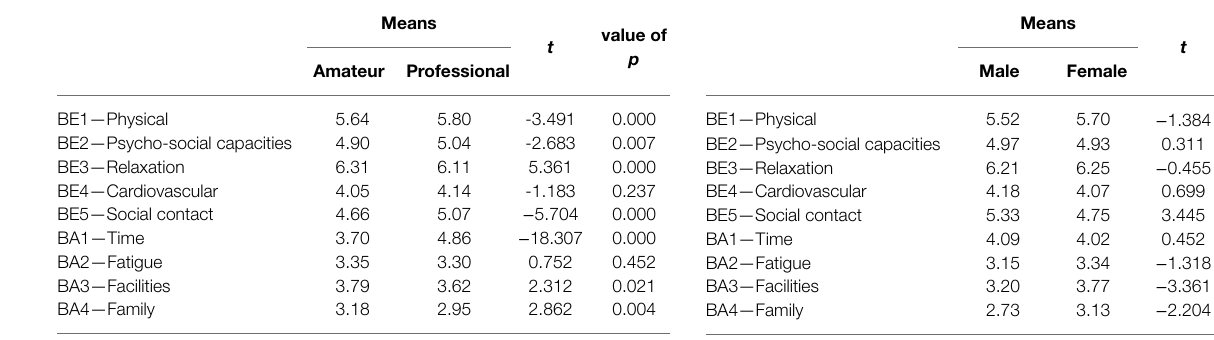
TABLE 7 | Benefit and barrier factor comparison between male and female horseback